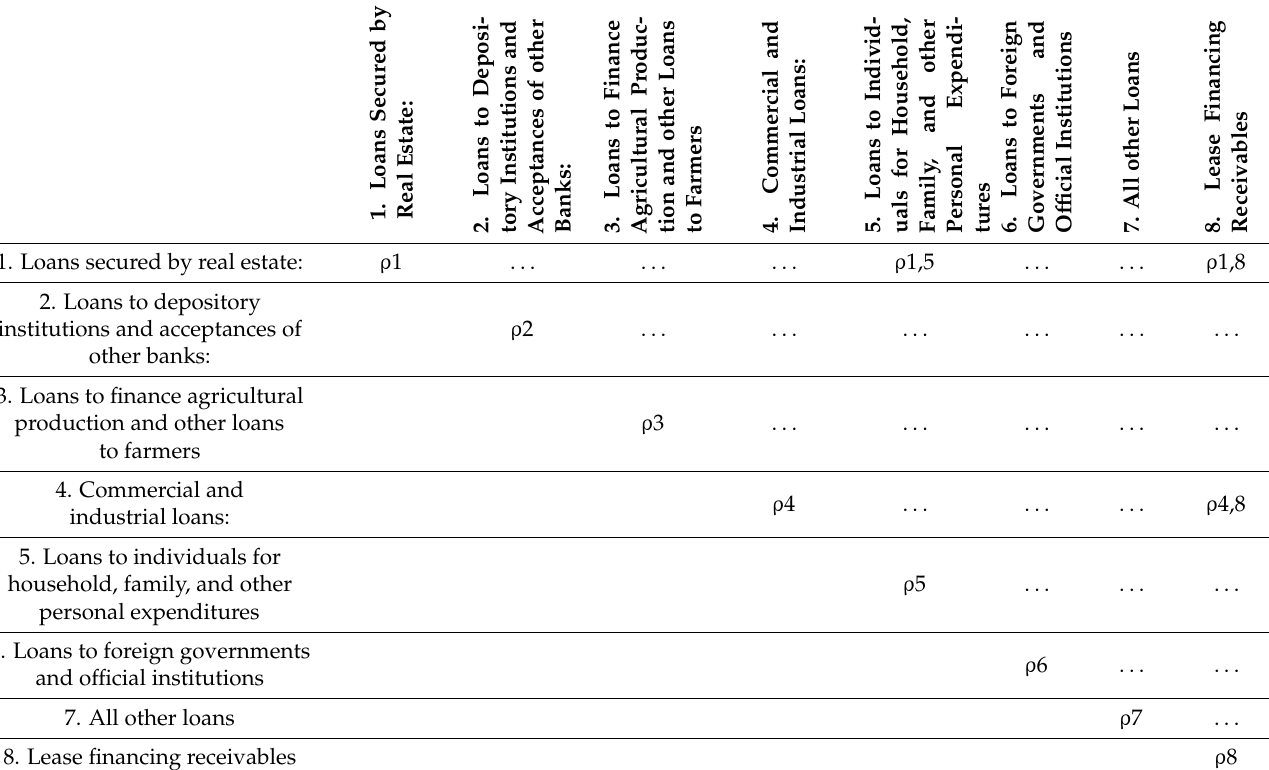
Table 1. Asset correlation matrix—proposed